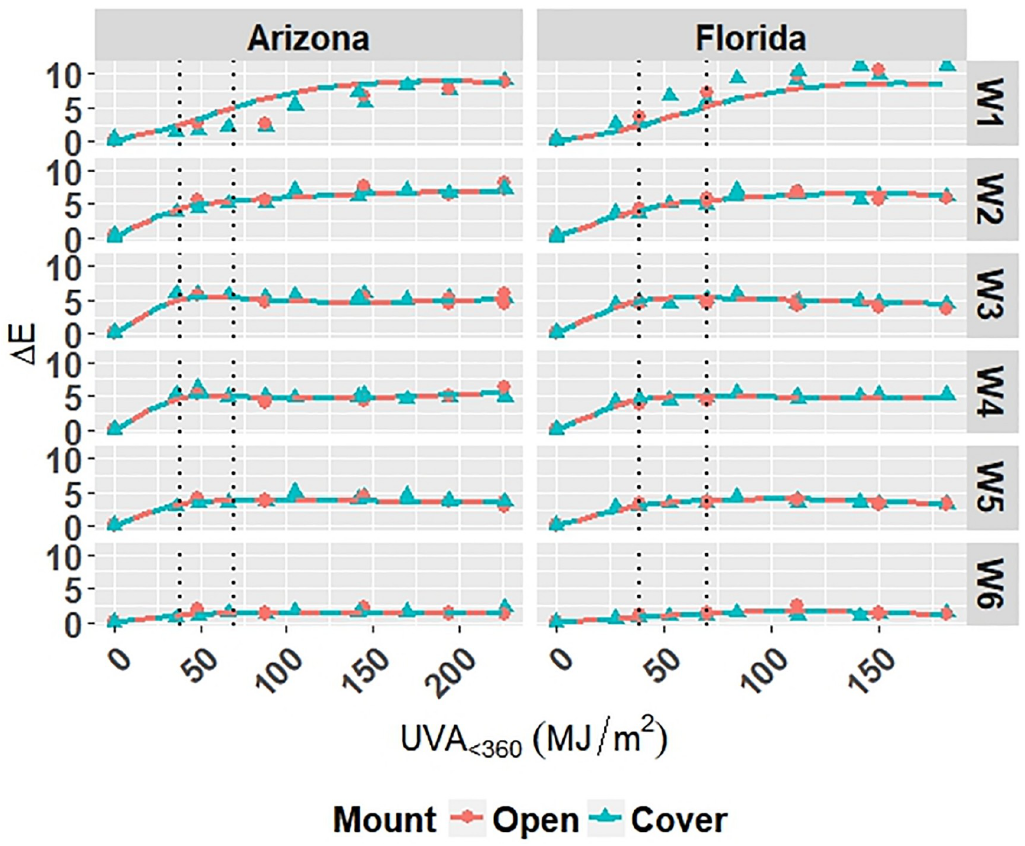
Fig 4. The change in Δ E for white grades of PET under outdoor exposures with the model curves superimposed on the data. Points represent the measured data and solid and dashed lines represent the models. Vertical, dotted lines represent the location of natural spline